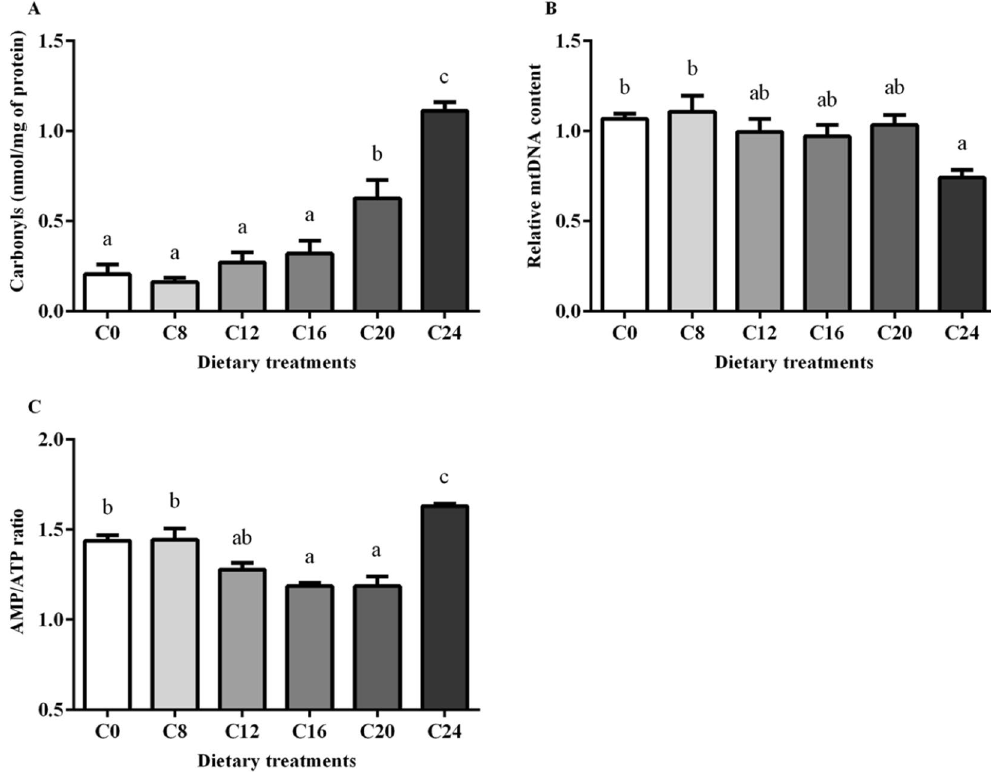
Figure 2. Protein carbonyl content ( A ), mtDNA content ( B ) and the AMP/ATP ratio ( C ) in skeletal muscle of olive flounder. All data were expressed as mean ± SE. Values with different letters means significant differences (P < 0.05, Tukey’s